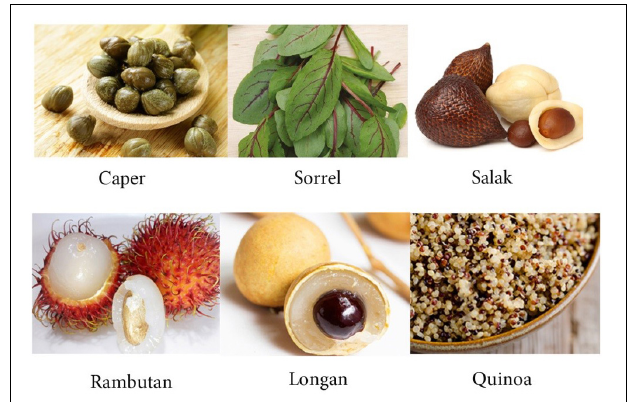
FIGURE 2 | The six selected vocabulary items. Images reproduced with permission from www.pinterest.com.